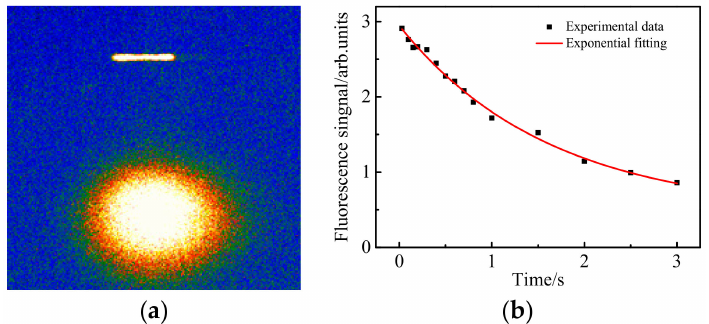
Figure 3. ( a ) Image of the 1-D optical lattice; ( b ) Lifetime of the atoms trapped in the optical lattice.